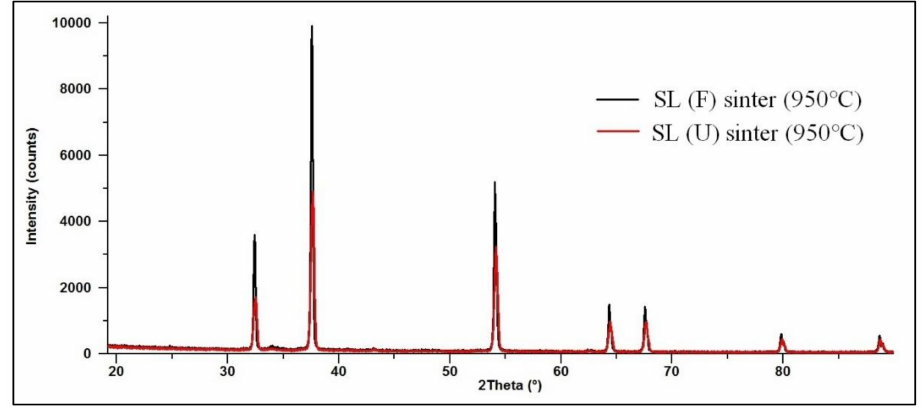
Figure 5. X-ray powder di ff raction patterns of analyzed SL (F) and SL (U) sinters prepared at 950 ◦